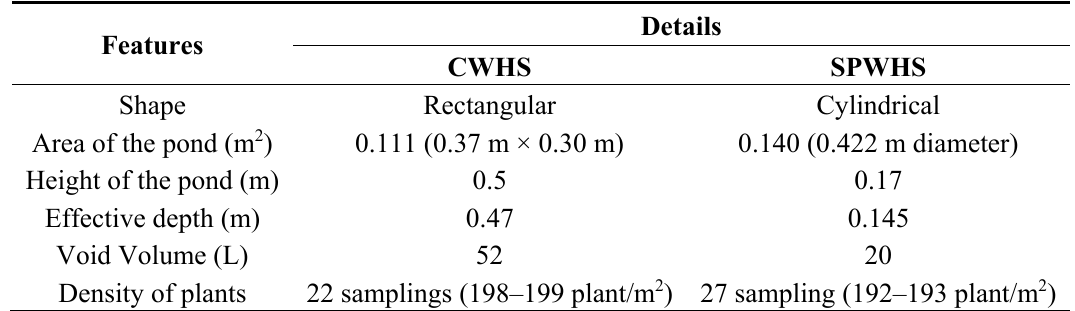
Table A1. Experimental plant details of conventional and shallow pond water hyacinth treatment systems